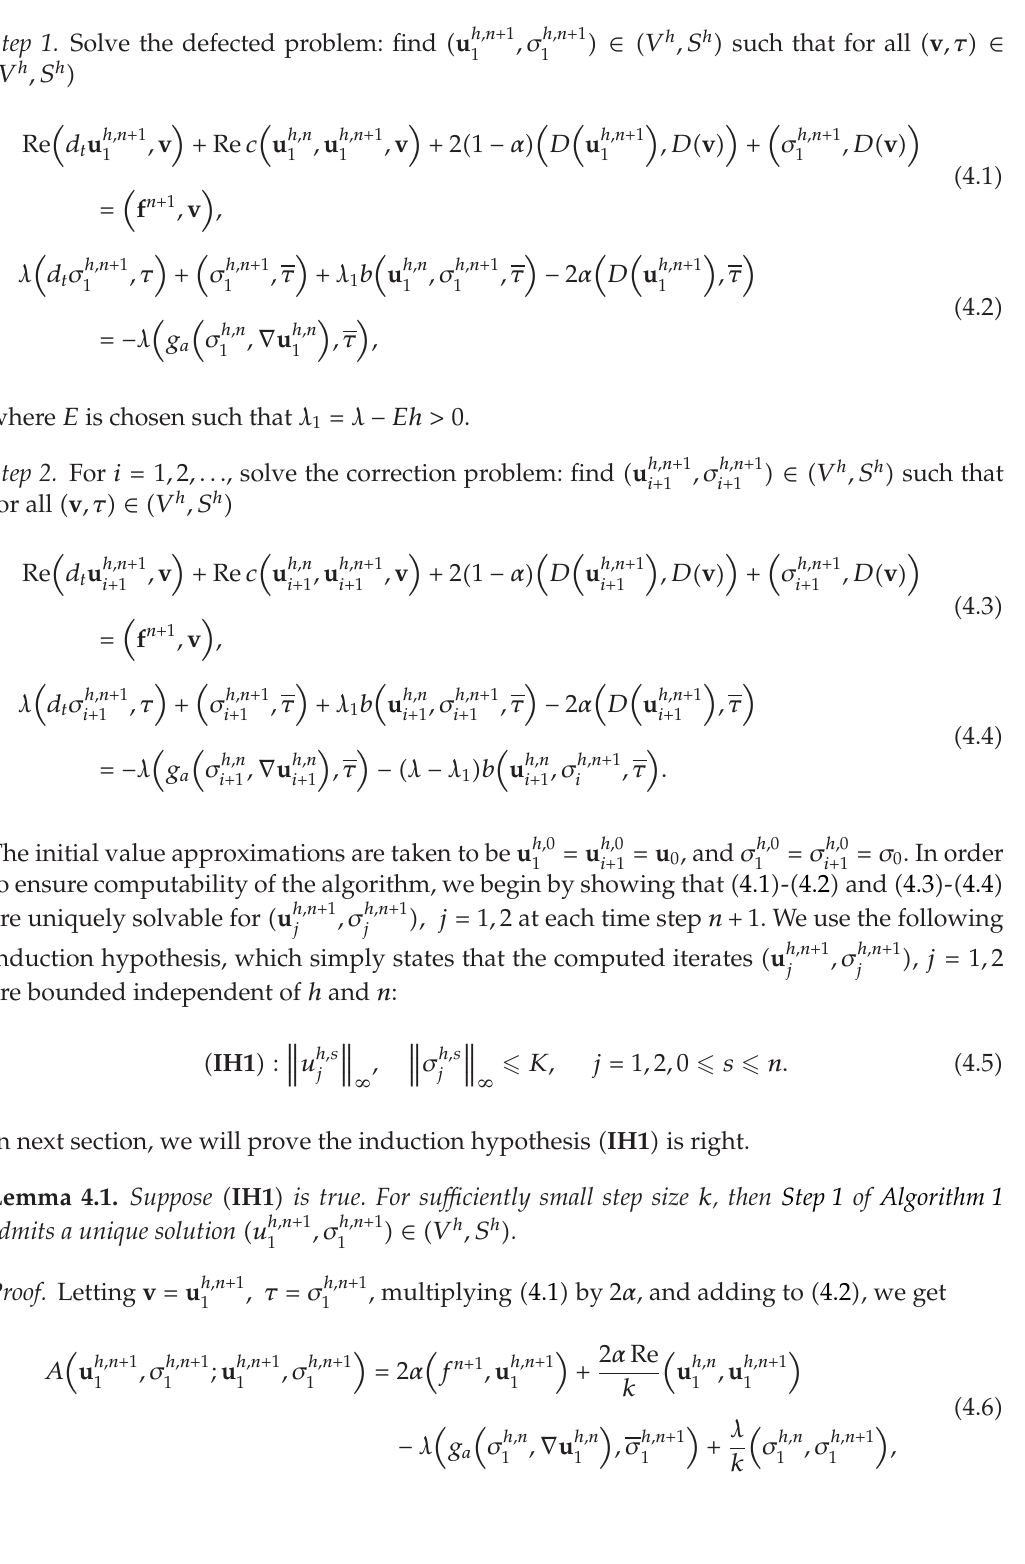
Algorithm 1 (cid:2) Defect-correction method (cid:3)